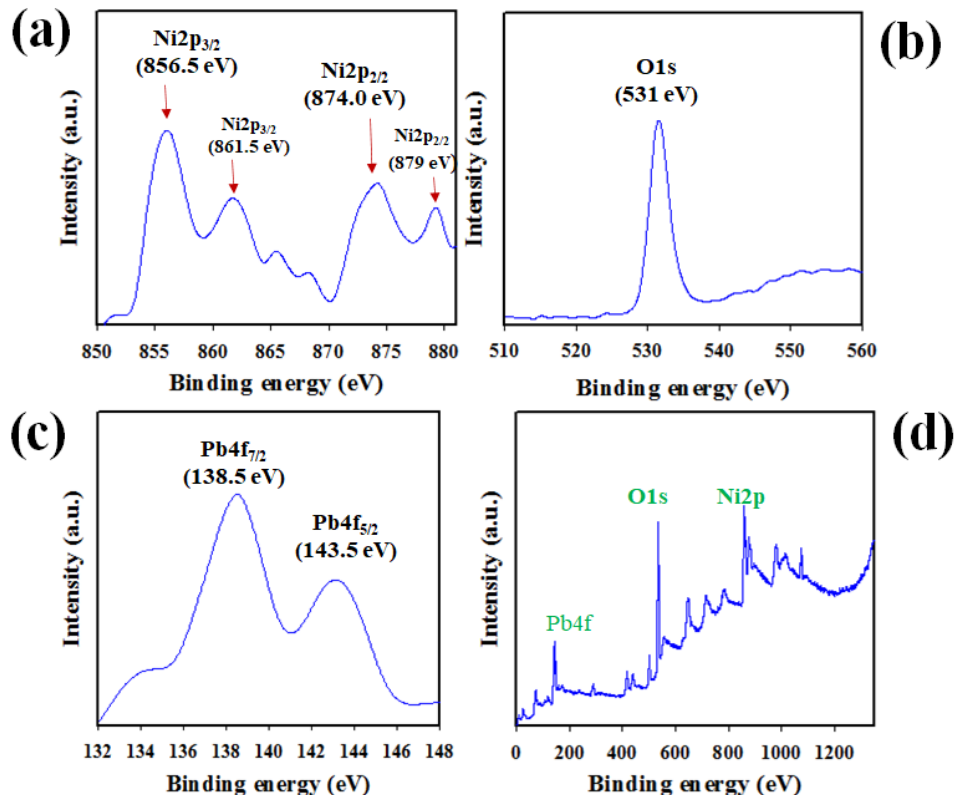
Figure 4. ( a ) The spin orbitals of Ni2p level, ( b ) the orbital O1s, ( c ) the spin orbitals of Pb4f level, and ( d ) XPS spectrum of PbO-doped NiO NCs.